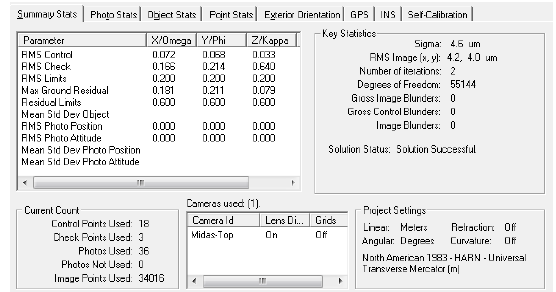
Table 7. Bundle Adjustment + EO + Control